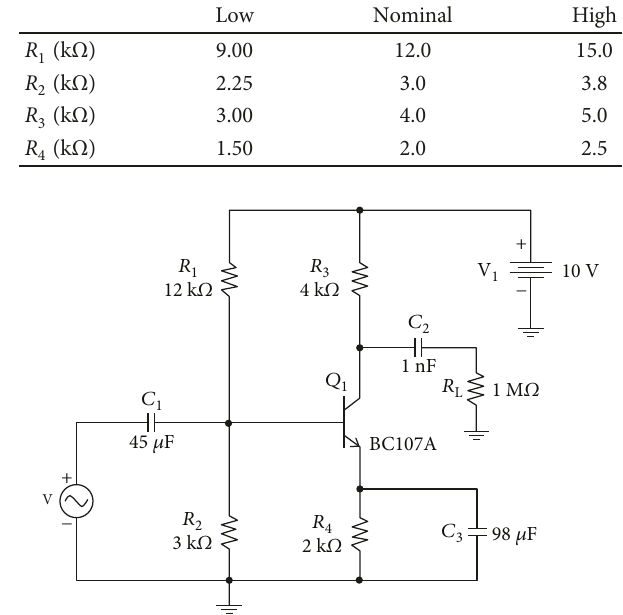
Figure 1: Nominal values of the ampli fi er